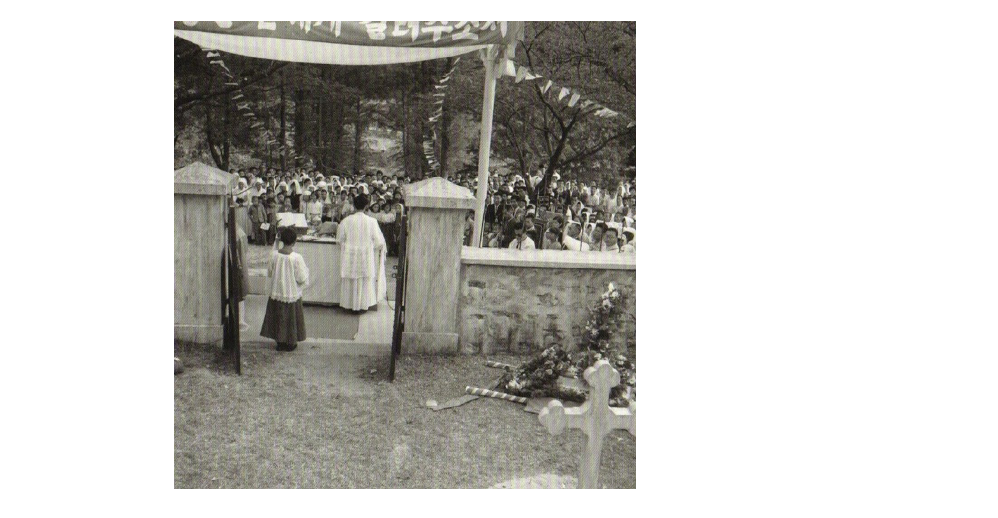
Figure 14. Image dated 26 September 1965 [source: Father Mark Kang Do-Young’s Collection of Letters , p. 578].